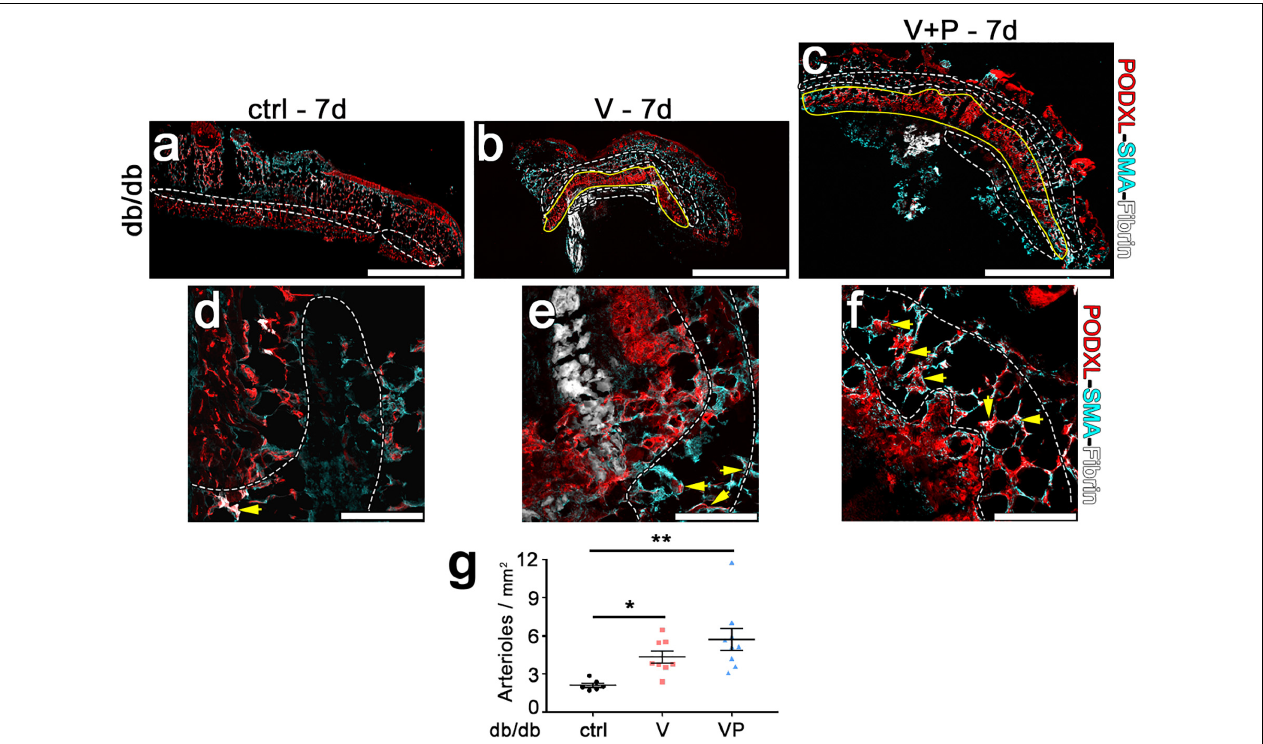
FIGURE 7 | Efficient arteriole formation adjacent to areas of angiogenesis in diabetic skin. (a–f) Arterioles were identified by immunostaining 7 days after implantation of control fibrin (ctrl) or V and VP fibrin gels in peri-angiogenic areas (marked in white) surrounding the angiogenic areas (marked in yellow). Endothelium is stained in red (Podocalyxin) and smooth muscle cells in cyan ( α -SMA). (d–f) Higher-magnification images of representative peri-angiogenic areas (in white). Yellow arrows indicate α -SMA-positive arterioles. Size bars = 2 mm (a–c) and 200 µ m (d–f) . (g) Quantification of the density of arterioles adjacent to the angiogenic areas (number of arterioles/mm 2 of area). Data are shown as mean values of each sample ± SEM ( n = 6–9 samples/group); ** p < 0.01, * p < 0.05 by Kruskal–Wallis